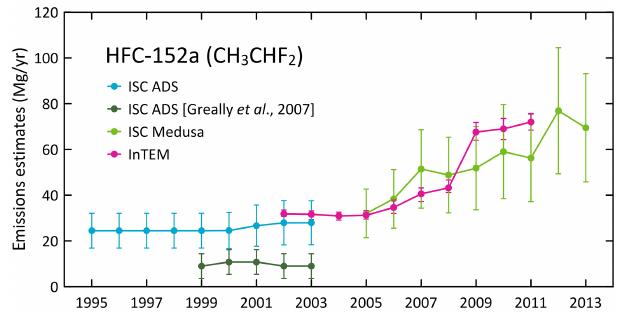
Figure 10. Australian HFC-152a emissions (Mgyr − 1 ) calculated from Cape Grim in situ observations via ISC, using ADS and Medusa data, and inverse modeling using InTEM (Medusa data). Australian emissions are derived from SE Australian emissions, scaled by population (see text). Uncertainties are 25th–75th per- centiles (InTEM) and 1 SD